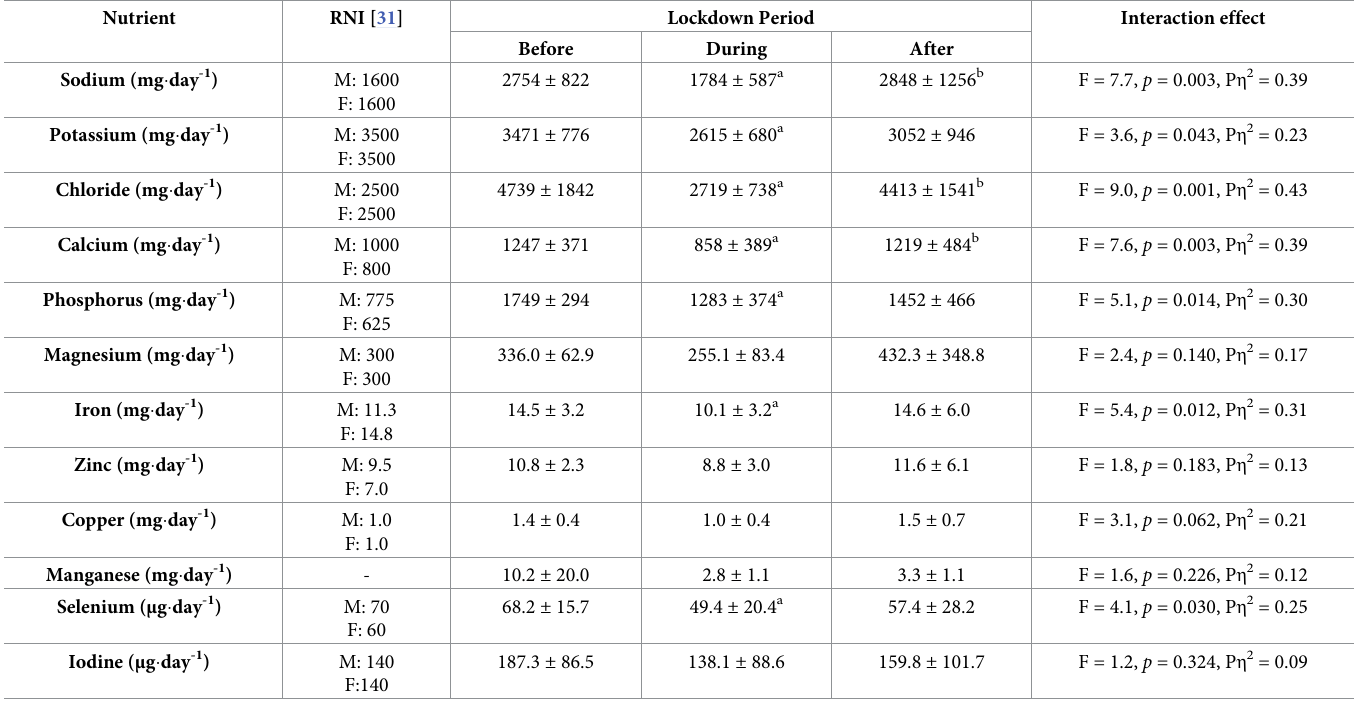
Table 4. Minerals and trace elements recorded in the diets of highly trained adolescent swimmers before, during, and after the COVID-19 lockdown. Nutrient RNI [31]